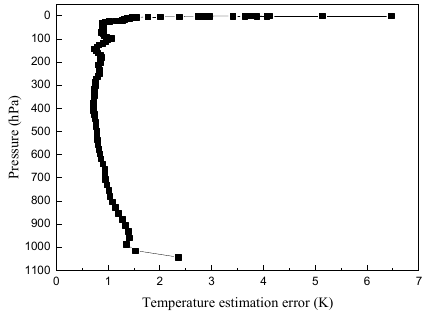
Figure 1. Estimation error profile of AIRS temperature data.